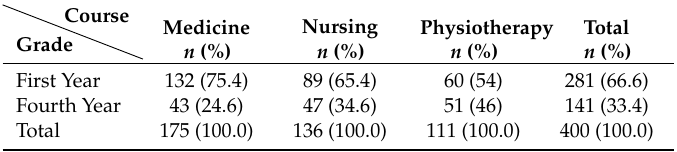
Table 1. Distribution of the research population by course and grade